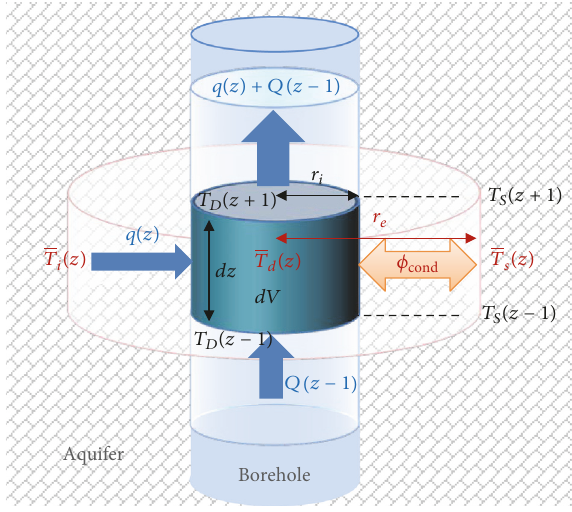
Figure 3: Heat budget at the borehole